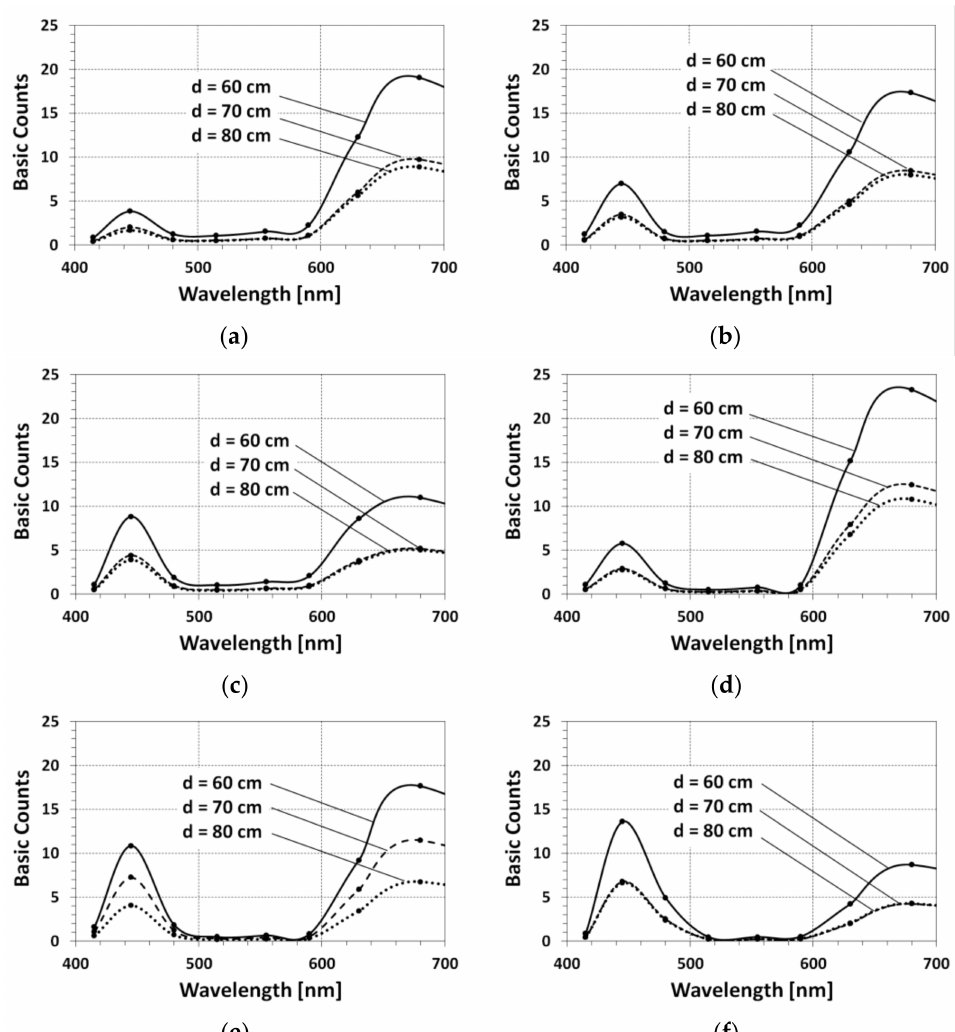
Figure 3. Light spectra of the 6 light combinations considered in the DoE, at the 3 different LEDs to plants distances, d . ( a ) LR12, ( b ) LR13, ( c ) LR14, ( d ) LR22, ( e ) LR33, ( f )